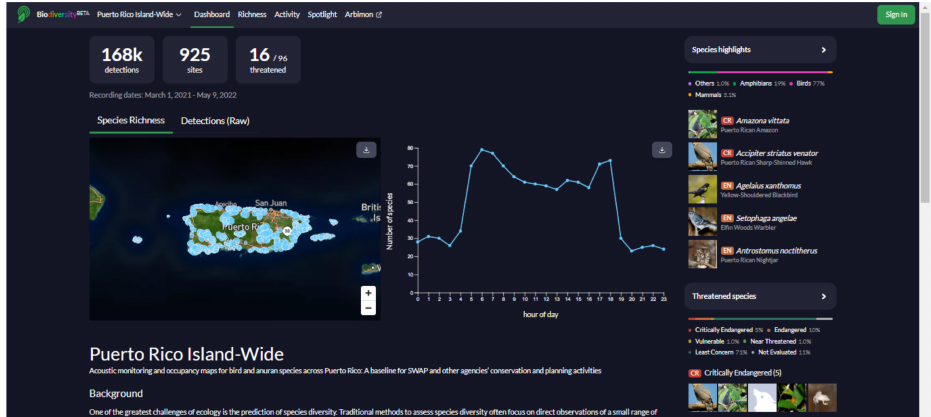
Figure A19. Dashboard: This page presents an overview of the project, including background information, objectives, funding, and stakeholders. General results are also presented, such as the total number of detections, sampling sites, species detected, and the number of species in each threat category according to the International Union for Conservation of Nature (IUCN). This page also features a map with all sampling sites and the number of species detected at each